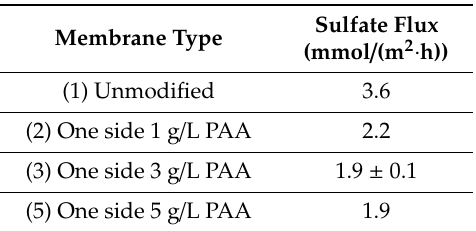
Table 8. Summary of the sulfate flux results for the one side PAA-modified AEMs as a function of the absence / presence of humic acid in the feed